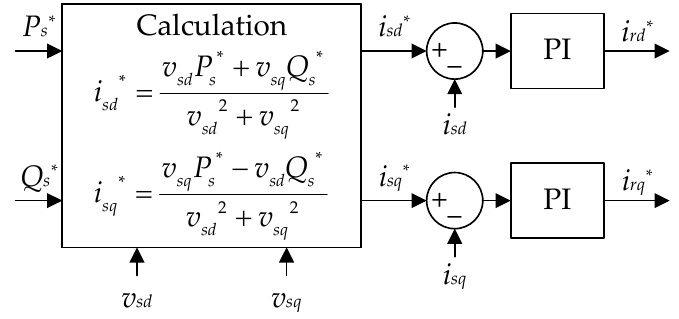
Figure 4. Block diagram of the proposed decoupled control.